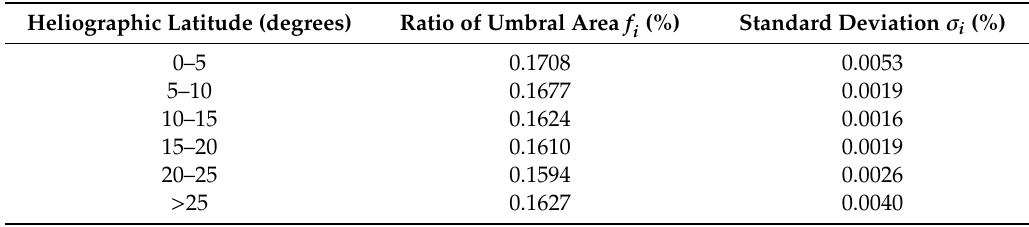
Table 1. Sunspot umbral area per latitude.